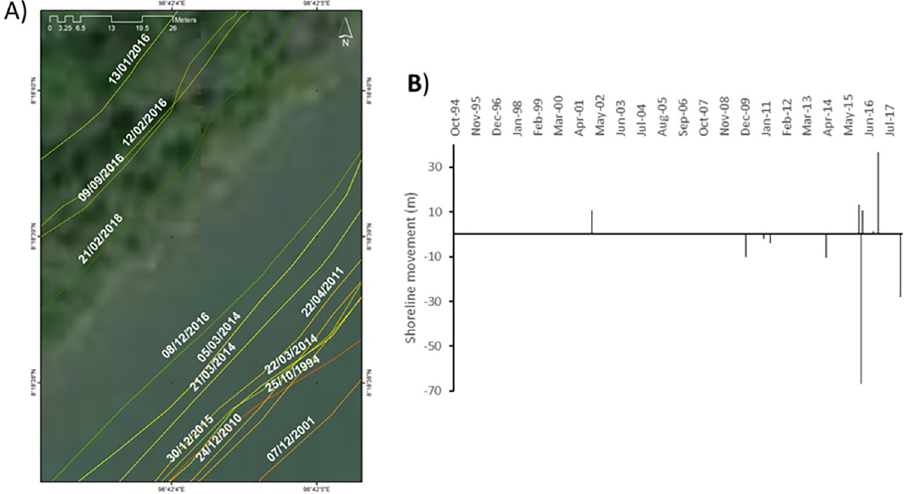
Fig 11. Representations of the shoreline movements observed during the survey period in site 6. A) Visualisation of the shoreline positions for the highest water level marks digitised with CoastSat. B) Shoreline movements measured using DSAS between two consecutives chronologically ordered digitised shorelines; negative values correspond to erosion and positive values to accretion. Basemap satellite images accessed from World Imagery ESRI Tile Layer. Credits: Esri, Maxar, GeoEye, Earthstar Geographics, CNES/Airbus DS, USDA, USGS, AeroGRID, IGN, and the GIS User